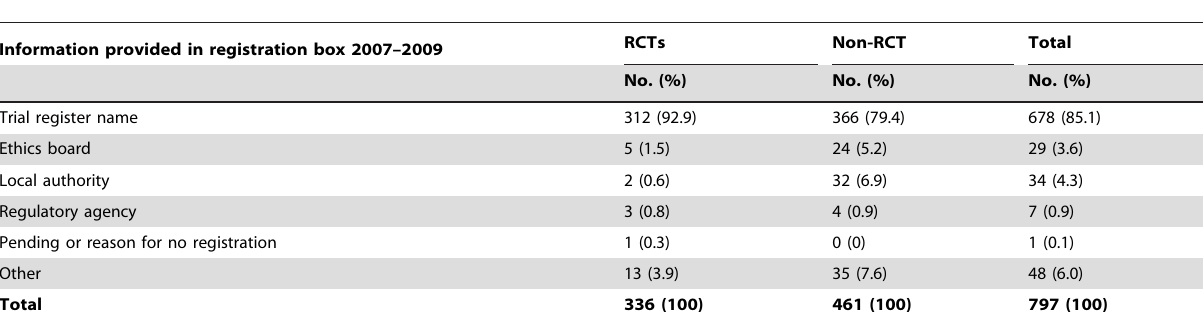
Table 3. Information provided in registration box by authors, compared by RCT status.